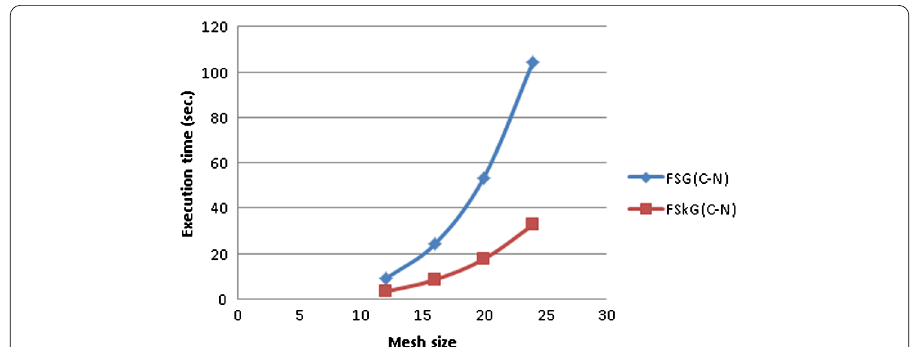
Figure 11 Graph of execution time (sec.) when α = 0.70 of Example 2